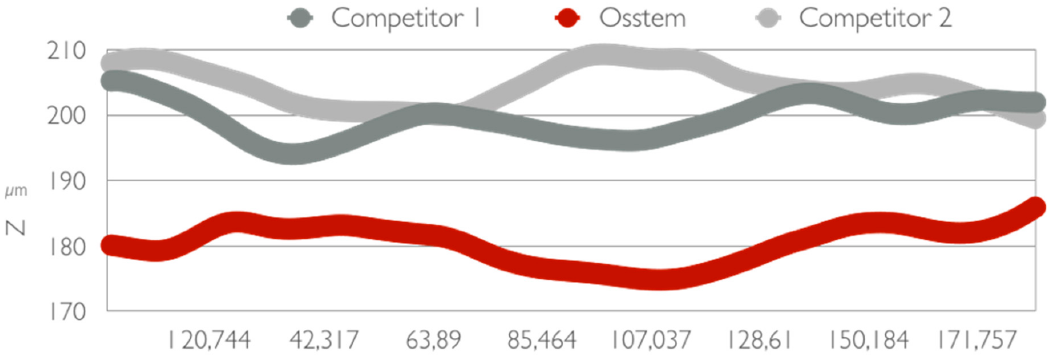
Figure 7. Roughness differences .